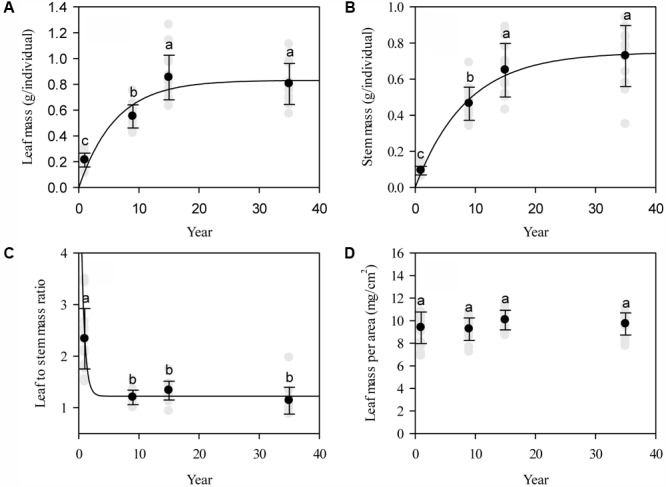
Patterns of individual biomass accumulation (A) and allocation (mean ± SD) in leaves and stems (B–D) of Leymus chinensis following grazing exclusion in a degraded pasture. The patterns of leaf mass (r = 0.85, P < 0.001) and stem mass (r = 0.90, P < 0.001) are fitted by an exponential rise to the maximum, whereas the leaf to stem mass ratio (r = -0.82, P < 0.001) displays an exponential decay. Different superscripts denote significant differences (P < 0.05).